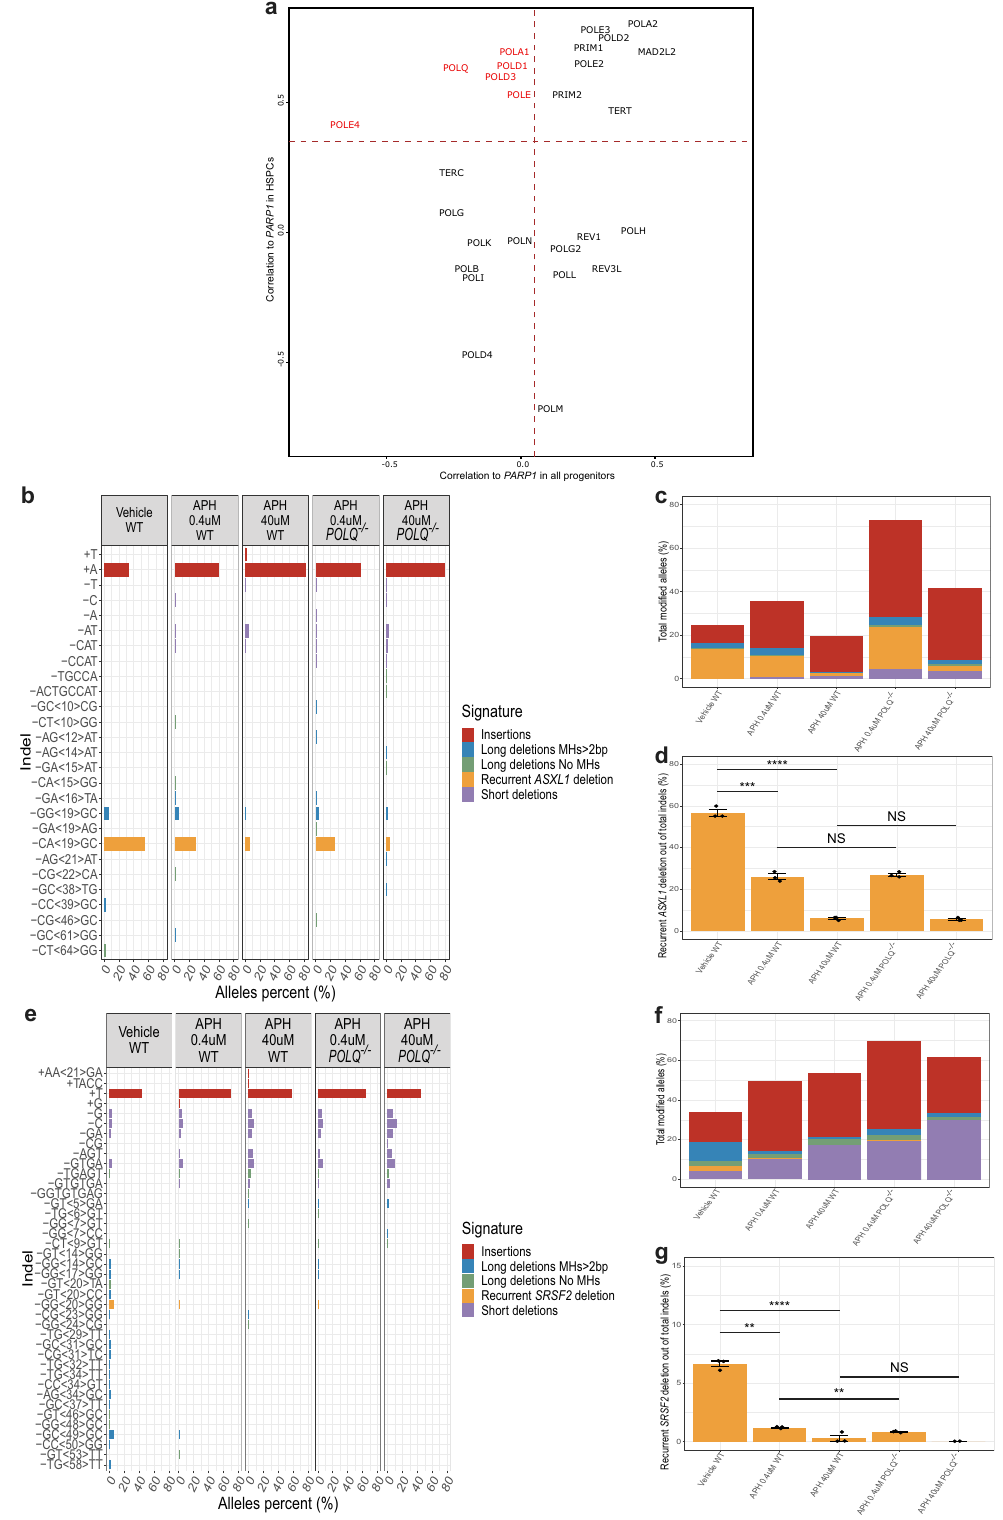
sgRNAs were re-suspended in IDTE buffer (PH 7.5) to a fi nal concentration of 100 uM. RNP complex for each reaction were generated by mixing 1.2 ul sgRNA, 1.7 ul Cas9 protein (IDT) and 2.1 ul PBS followed by incubation for 10min at 20 degrees. Electroporation reactions . All electroporation reactions were performed using the 16-strip Lonza 4D nucleofector kit. Pre-electroporated cells were washed in